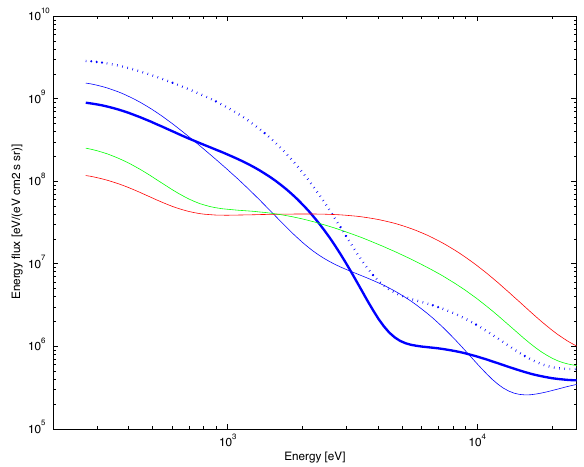
Fig. 4. Energy spectra of the source populations giving rise to struc- tured precipitation at 05:40 (blue line), 06:37 (bold blue) and 06:45 (dotted blue) UT and diffuse precipitation (sample from 05:25 UT, green line and 06:02 UT, red line).